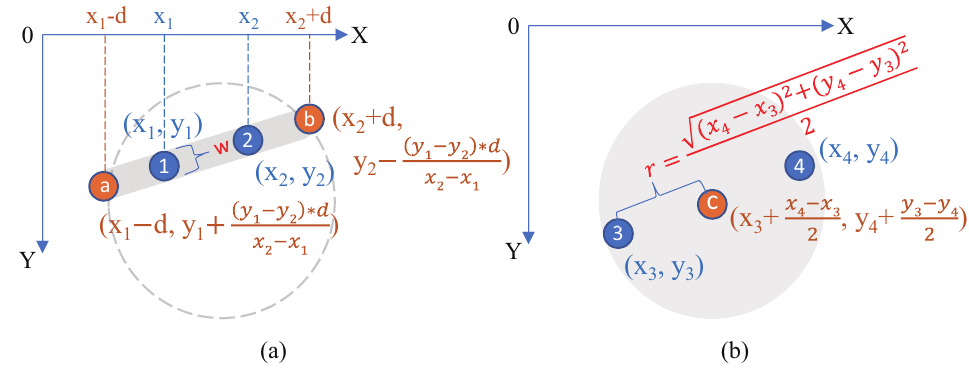
Figure 6. Algorithms for retrieving key point coordinates while the head is tilted: ( a ) Eye line mosaic refer to Figure 4. ( b ) Face mosaic refer to Figure 5.